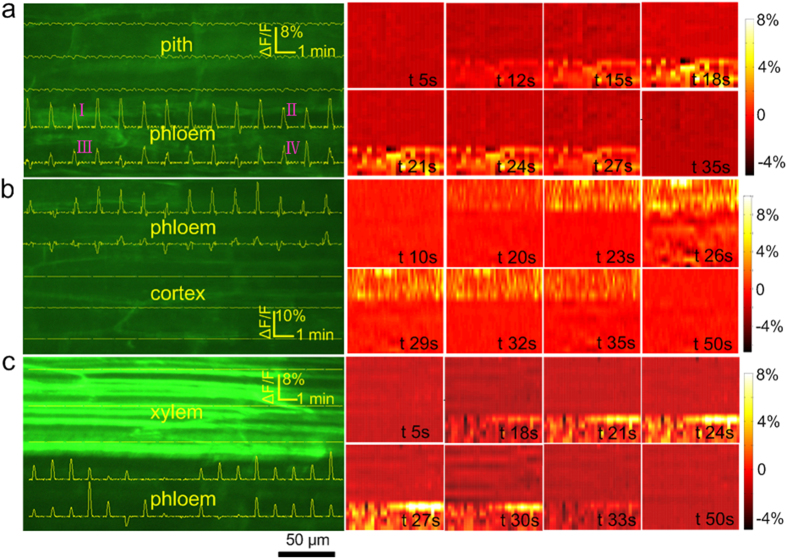
Typical optical recording of a single AP.The AP was distributed in the phloem region. (a) The ΔF/F curves are plotted on the left side. Each curve represents the change in the fluorescence intensity of the region around it with a spatial size of about 20 μm × 20 μm. From the signal curves numbered I, II, III and IV, similar ΔF/F waveform and amplitude can be observed, and in the whole region, the maximum amplitude of the ΔF/F signal is about 8%. On the right side, the time lapse ∆F/F images, are presented. The stimulus was applied at the fifth second. Following the stimulus, the ∆F/F change can be clearly observed in the phloem region. (b,c) The ∆F/F curves and the time lapse ∆F/F images of the other two samples. All of the images indicate that the AP is mainly distributed in the phloem region.